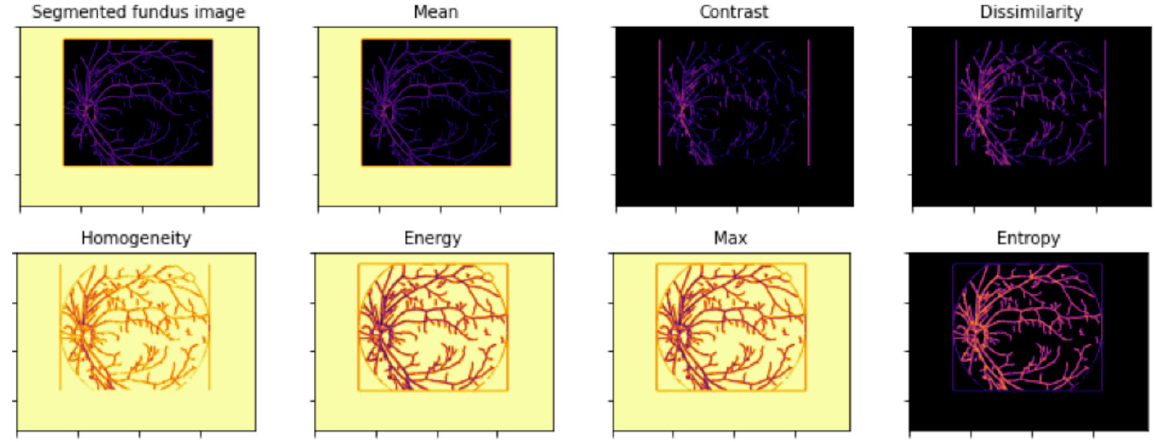
Figure 12. Visualization of GLCM features of a DR fundus sample. Table 3. Model’s scores on test